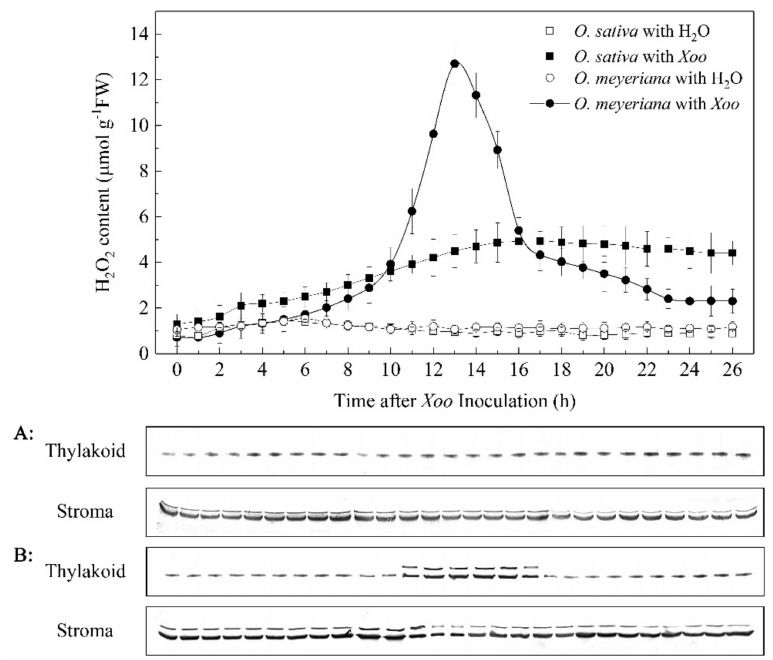
Figure 2. E ff ect of Xoo inoculation on H 2 O 2 content in the leaves of Dalixiang and O. meyeriana during a 26 h test period (upper panel) and rubisco activase (RCA) content in the thylakoid membrane fraction and soluble stroma fraction of chloroplasts in Dalixiang and O. meyeriana (lower panel). ( A ): Dalixiang, ( B ): O. meyeriana . Intact chloroplasts were isolated from rice leaves at di ff erent times after Xoo inoculation. The protein samples were loaded on the basis of 5 µ g total protein and western blot analysis was performed with an antibody raised against